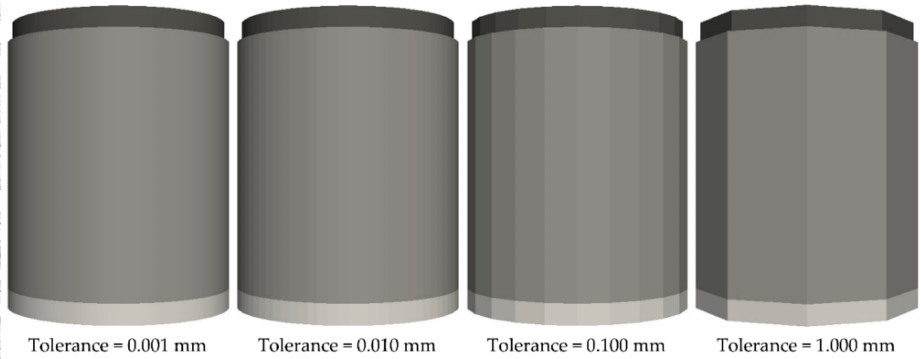
Figure 4. Geometries used to analyse the effects of the conversion